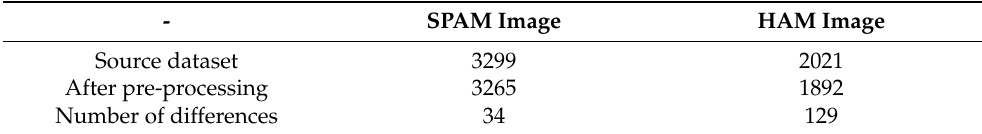
Table 3. Components of Dredze